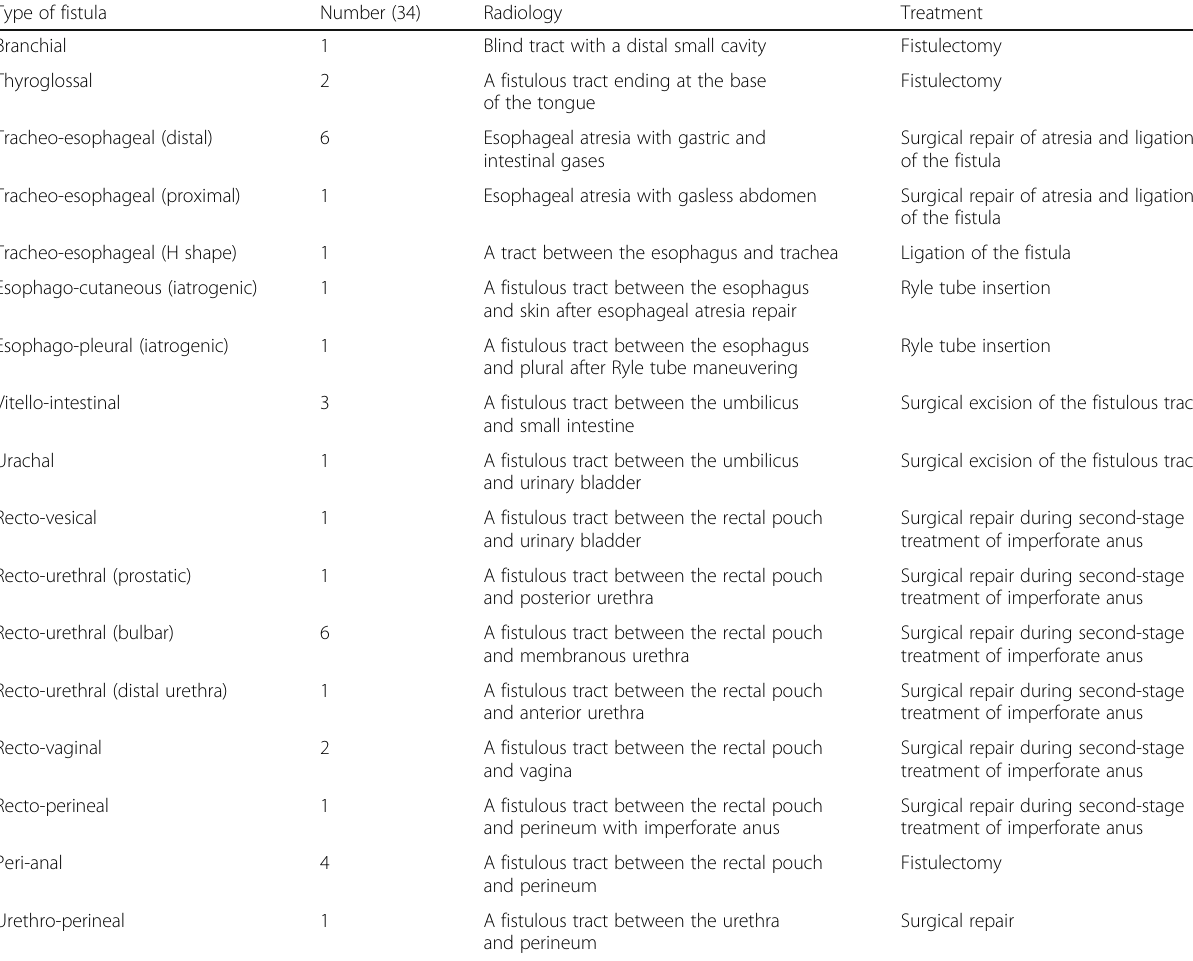
Table 1 Types, numbers, and radiological and surgical data of neonatal and infantile fistulas Type of fistula